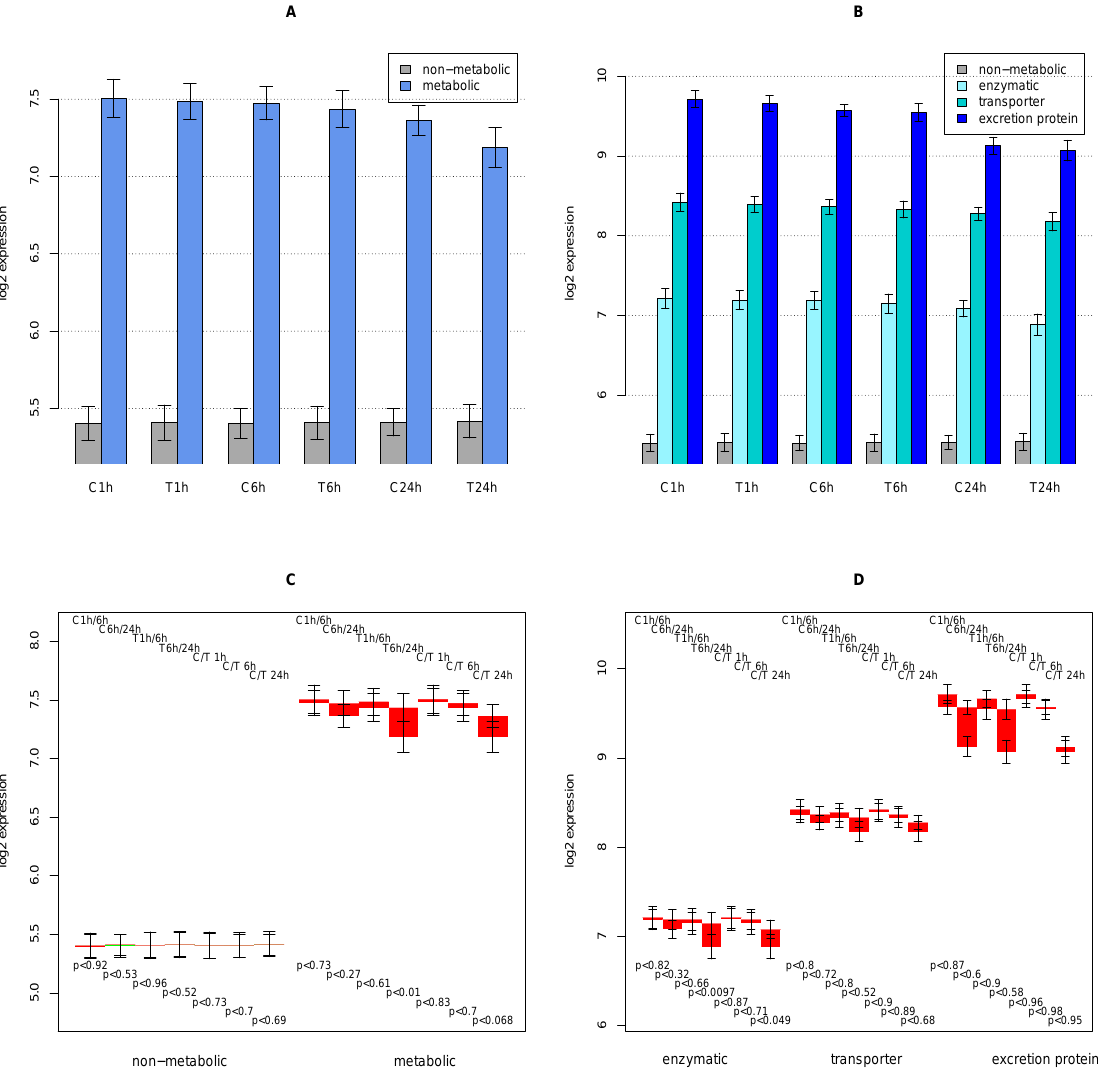
Figure 1. A Average expression values of metabolic genes (upon mapping to HepatoNet1) vs. all other genes, by expression profile (C = control, T = TGF β treated). In B , the set of metabolic genes is split into genes encoding enzymes, transporters, and selected excretion proteins. Error bars indicate average standard deviation of the 3 repeat experiments. C and D show differences of average expressions. Red bars indicate down-regulation and green bars indicate up-regulation. Either 2 time points in the control experiment are compared (e.g., C1 h/24 h) or the same time point of control vs. treated sample (e.g., C/T 24 h). P-values refer to the probability that the averages of the two series are equal, determined with the Welch’s t test [18] and the average RNA abundance values. The error bars refer to the average of standard deviation of the repeats, not the standard deviation of the gene abundances (which would be huge in this